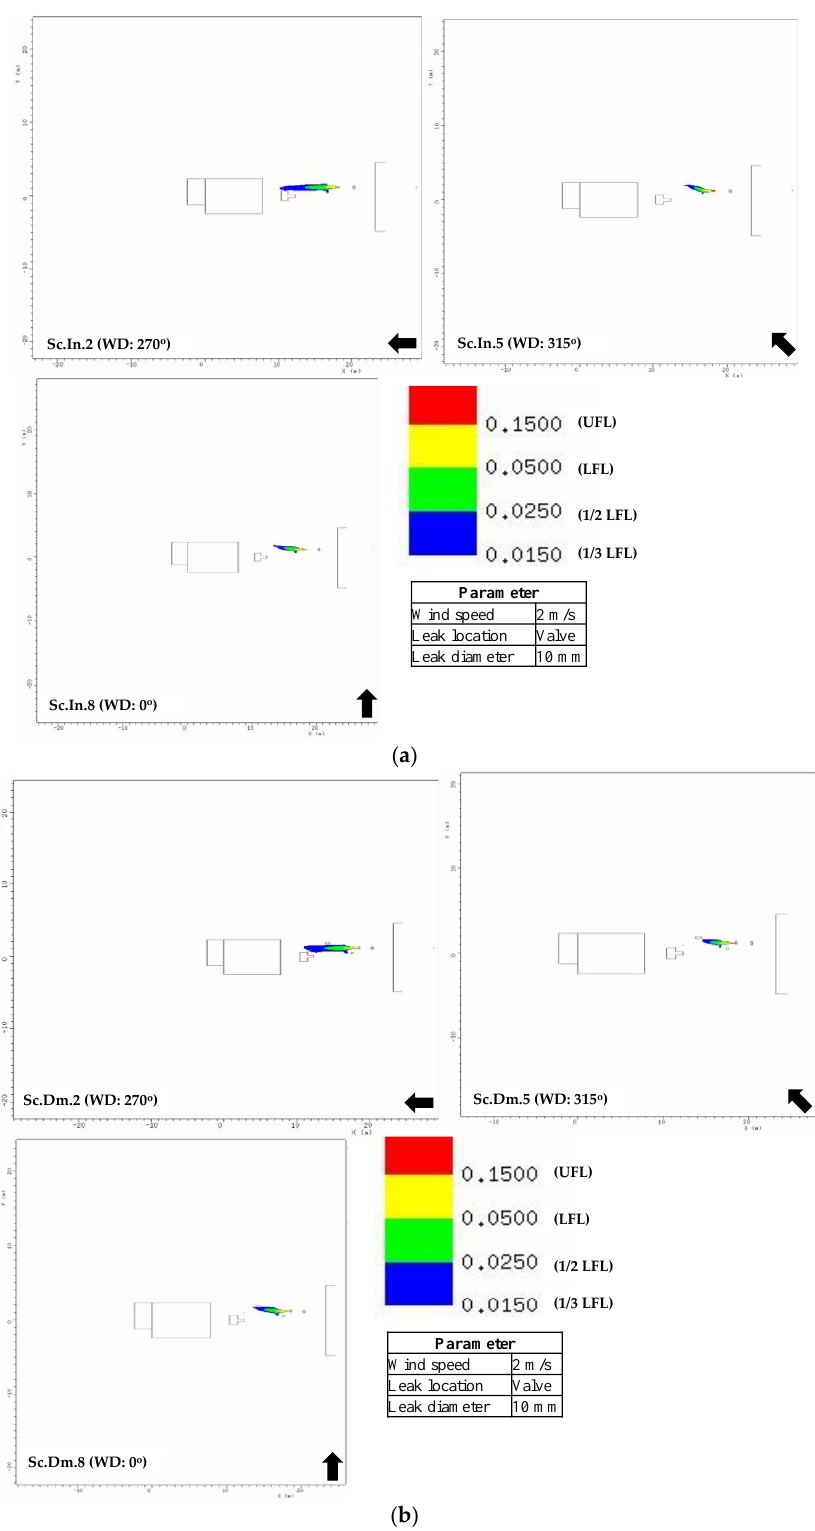
Figure 15. Gas contour plot for the 10 mm valve leak at 2 m/s for ( a ) intact and ( b ) damaged ships.